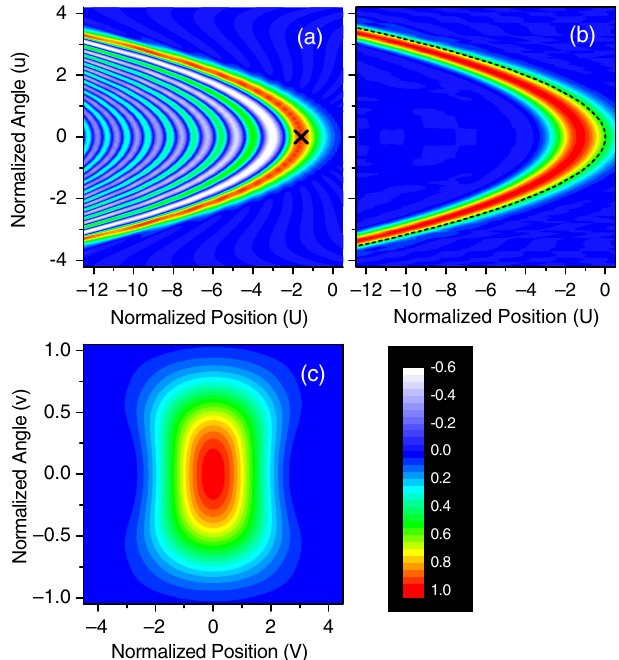
FIG. 1. Normalized Wigner function of BMR emitted by a single electron calculated on the ð U; u Þ plane sliced at ð V; v Þ ¼ ð 0 ; 0 Þ . (b) Same as (a), but σ U ¼ 1 has been assumed to investigate the effects due to the finite electron beam size in the horizontal direction. The dashed line shows the graphical plot of U ¼ − u 2 (refer to the text). (c) Same as (a), but on the ð V; v Þ plane sliced at ð U; u Þ ¼ ð − 1 . 6 ; 0 Þ .